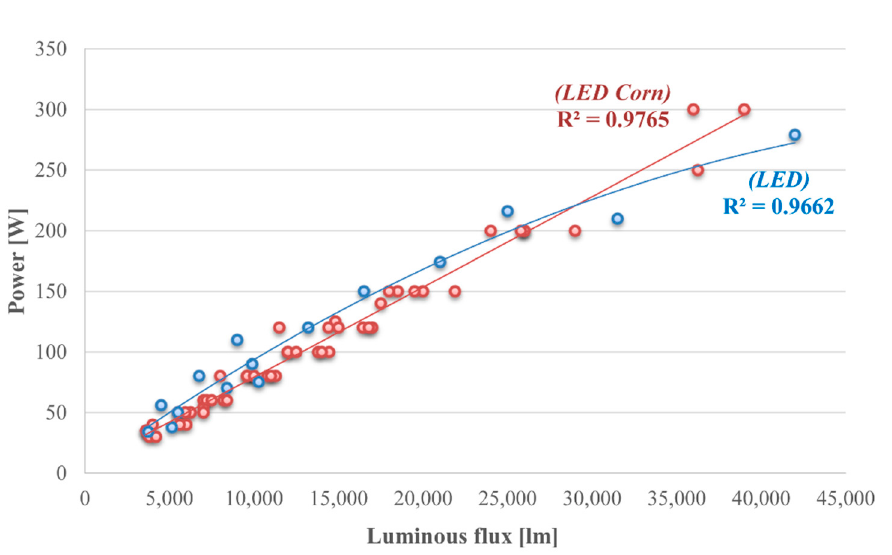
Figure 2. Power as a function of luminous flux for available LED street luminaires and LED corn bulbs. corn